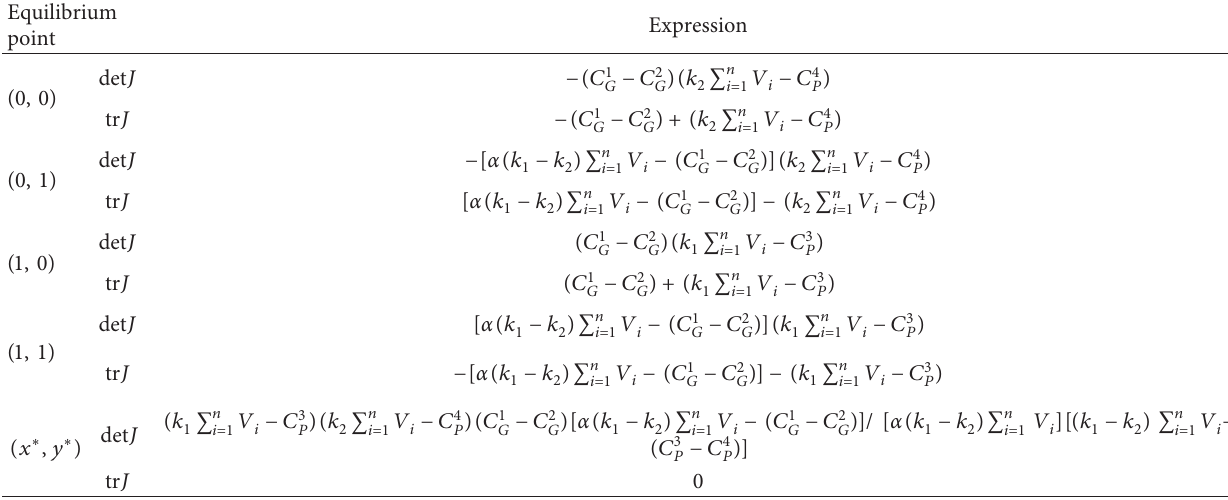
Table 5: The expressions of five